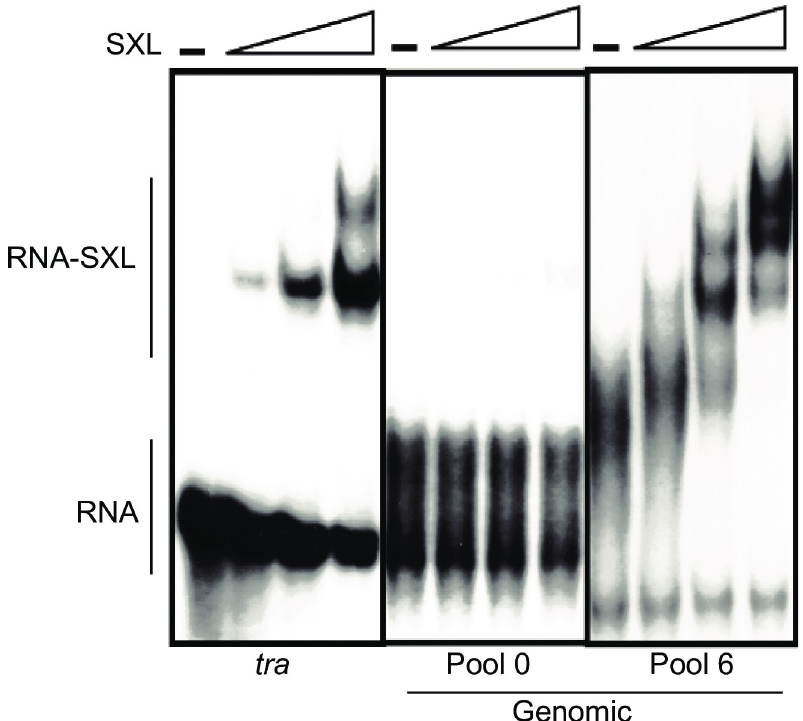
Fig 3. Binding of SXL to the RNA pools from the genomic SELEX library. Electrophoretic gel mobility assay was used to determine binding affinity of SXL with the non-sex-specific polypyrimidine-tract/3’splice site (a well characterized SXL binding site) of tra , the pool 0 RNA for the genomic library, and the pool 6 RNA of the SXL-selected sequences. No SXL is shown by the–lane, and increasing concentrations (three-fold successive increase) of the recombinant GST-SXL protein are shown by the triangles. The–lane shows the free (unbound) RNA, and RNA- protein complexes are shown under various SXL concentrations (166 ng/ μ l; 55 ng/ μ l; 18 ng/ μ l).